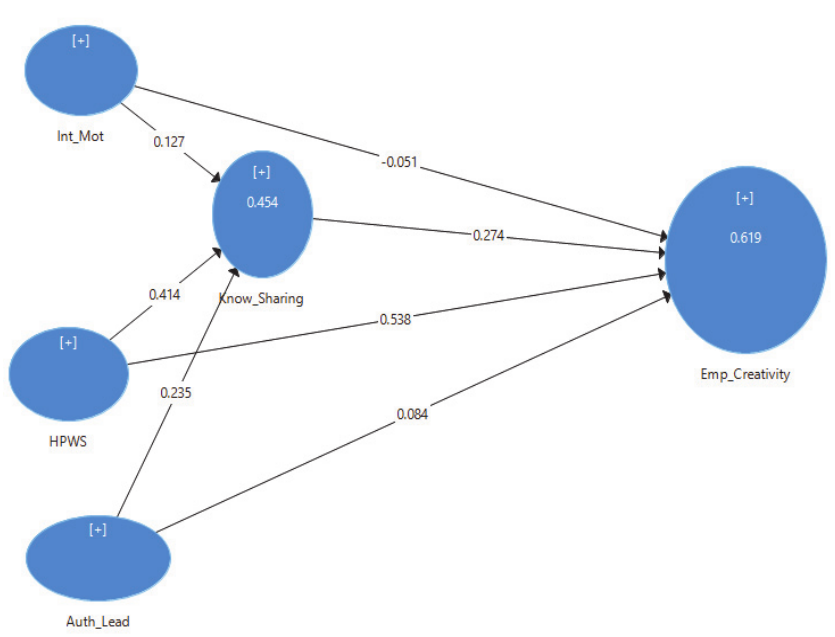
Fig. 2. The results of